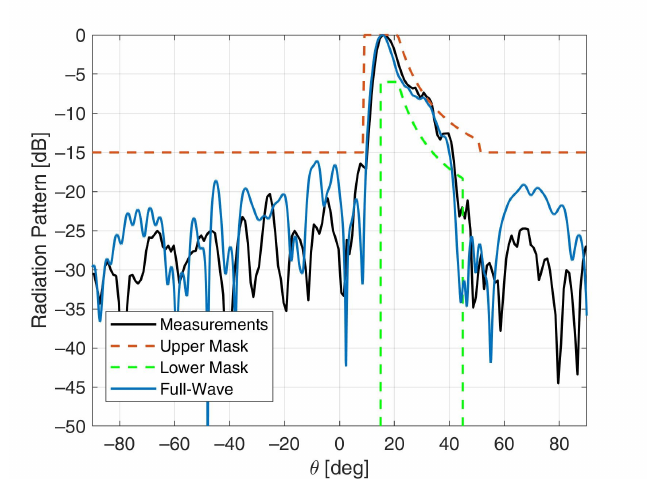
Figure 11. Radiation patterns in the E-plane at 31 GHz.